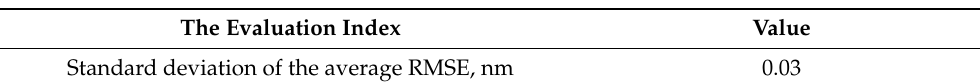
Table 2. The uncertainties of our model. The Evaluation Index Value Standard deviation of the average RMSE, nm 0.03